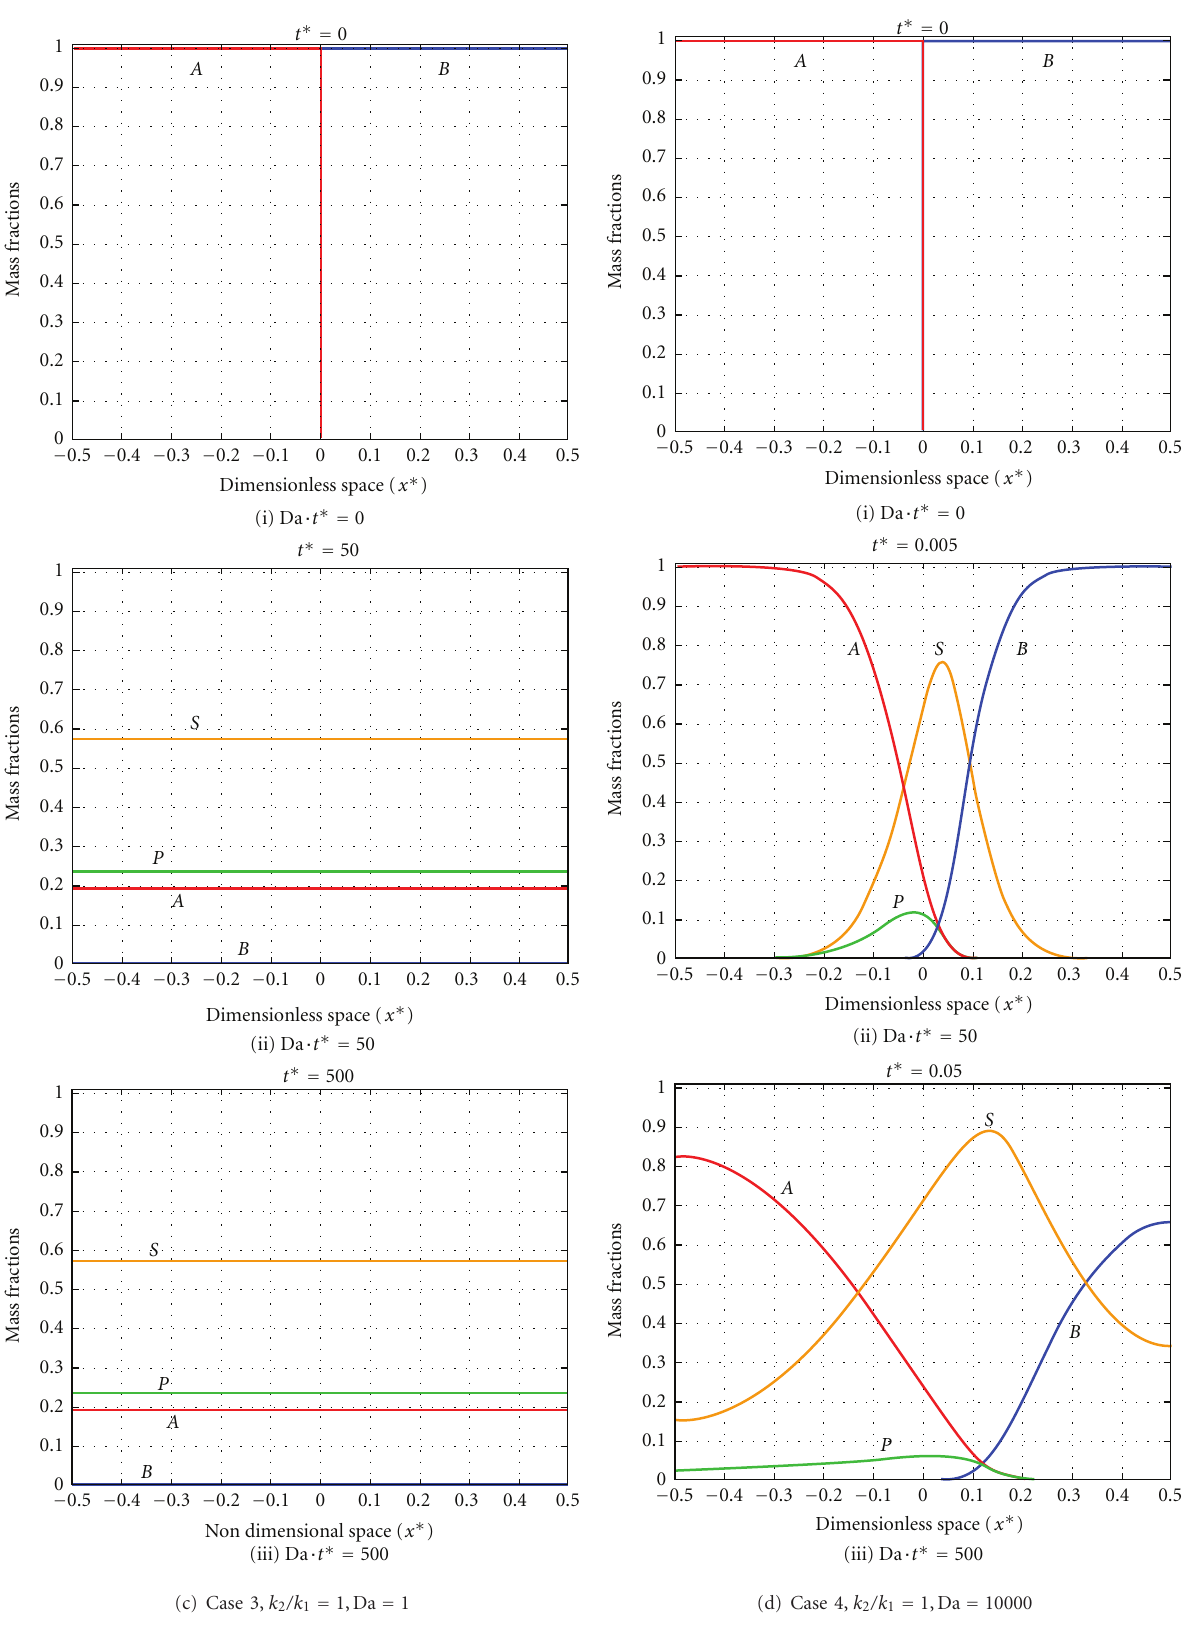
Figure 2: Spatial and temporal evolution of mass fractions for C-C cases (a) Case 1 ( k 2 /k 1 = 10 − 5 ,Da = 1); (b) Case 2 ( k 2 /k 1 = 10 − 5 ,Da